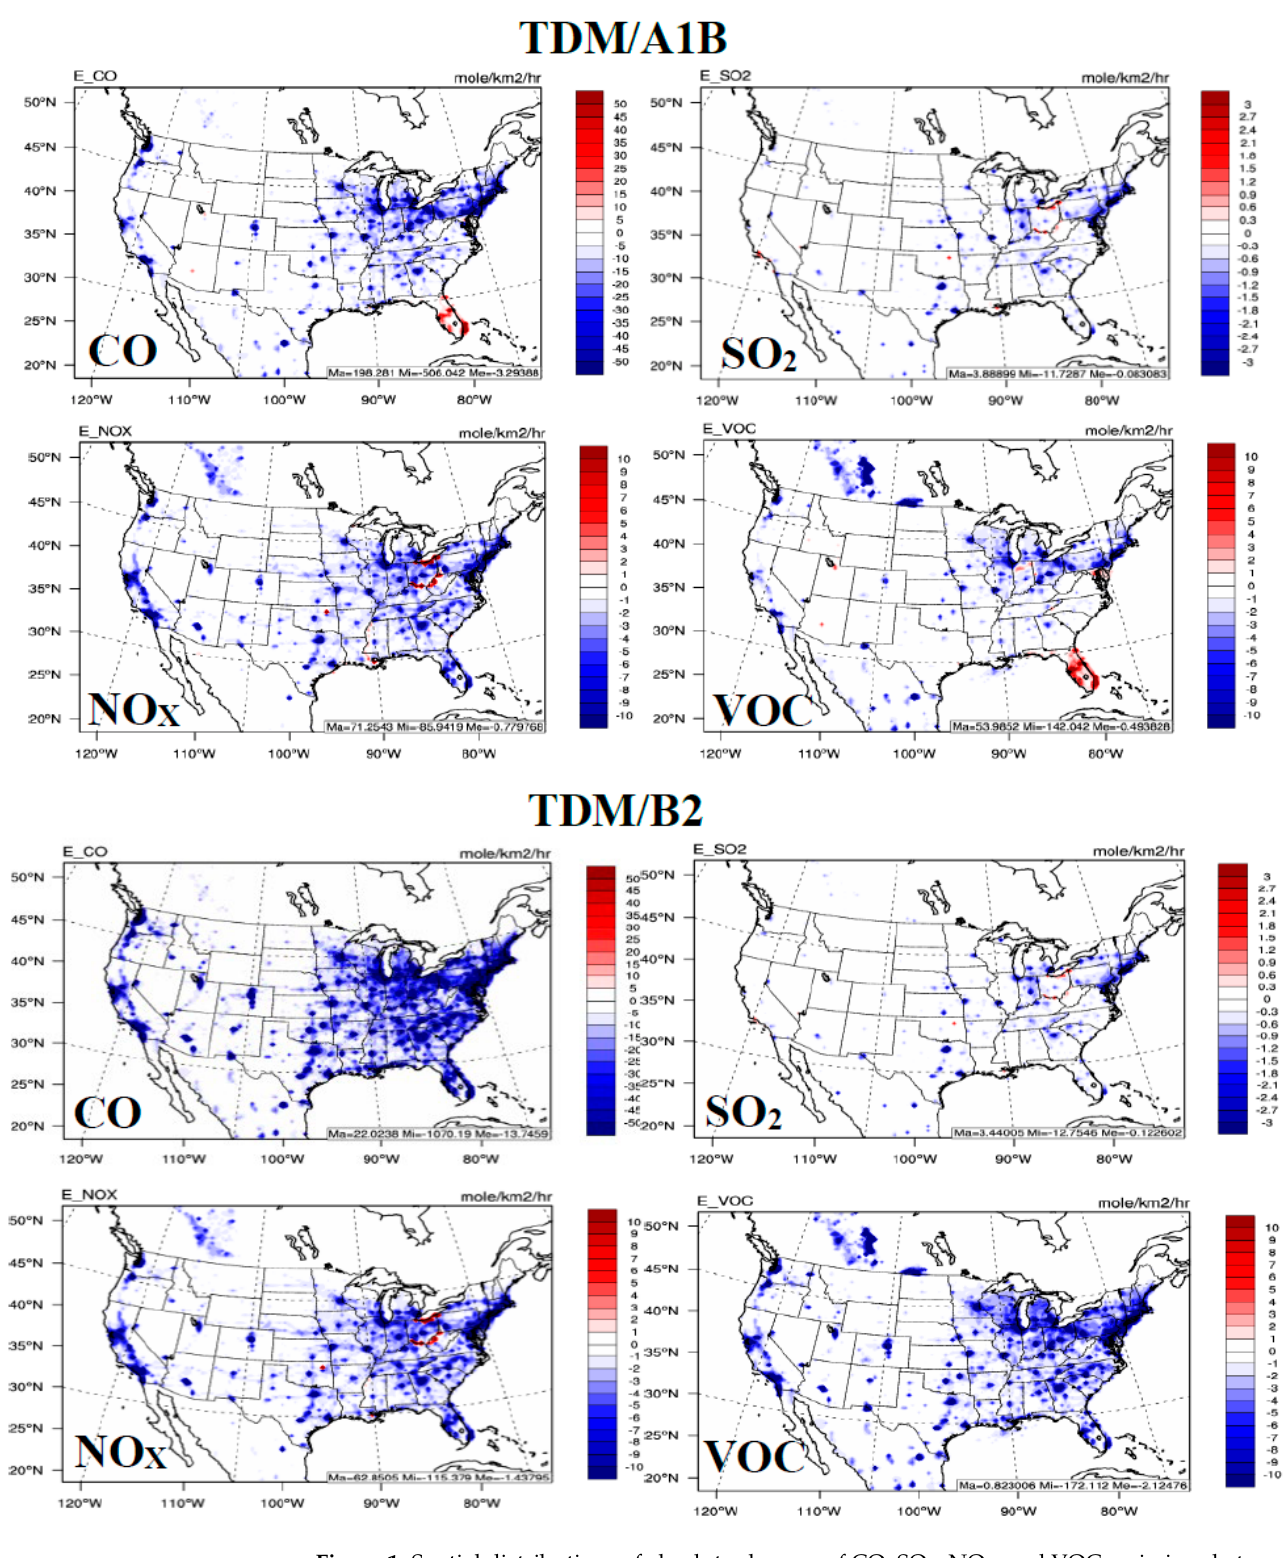
Figure 1. Spatial distributions of absolute changes of CO, SO 2 , NO x , and VOC emissions between annual average of future (2046–2055) and present, baseline (2005) conditions under the TDM/A1B ( top ) and TDM/B2 ( bottom ) scenarios.